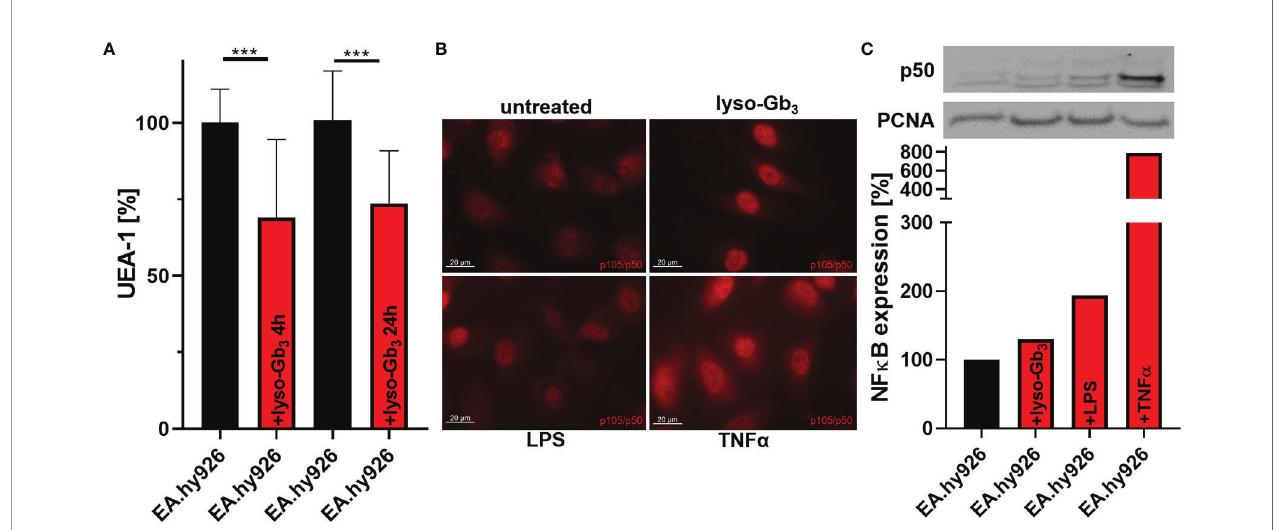
FIGURE 3 | Lyso-Gb 3 and AGAL-de fi ciency activate NF- k B-mediated glycocalyx degradation in endothelial cells. (A) Incubation of wild-type EA.hy926 cells with lyso-Gb 3 (200 nM) led to degradation of the glycocalyx. (B, C) Treatment of wild-type EA.hy926 cells with pathologic lyso-Gb 3 levels (200 nM), LPS (1 µg/ml in B and 100 ng/ml in (C) and TNF a (10 ng/ml) for 4 h results in increased nuclear NF- k B (p50 subunit) localization. Representative western blot of nuclear fractions and analysis from N=3 independent experiments. LPS, lipopolysaccharide; UEA-1, Ulex europaeus agglutinin I; lyso-Gb 3 , globotriaosylsphingosine. ***p < 0.001determind by students t